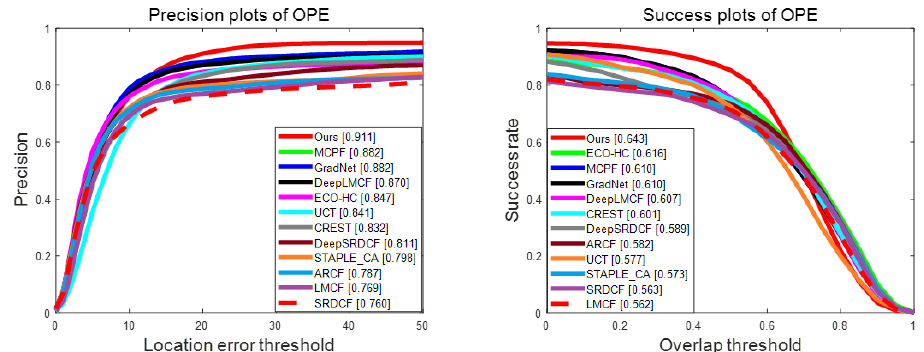
Figure 2. The overall tracking performances of precision and overlap success plots on OTB-50 dataset using OPE evaluation.